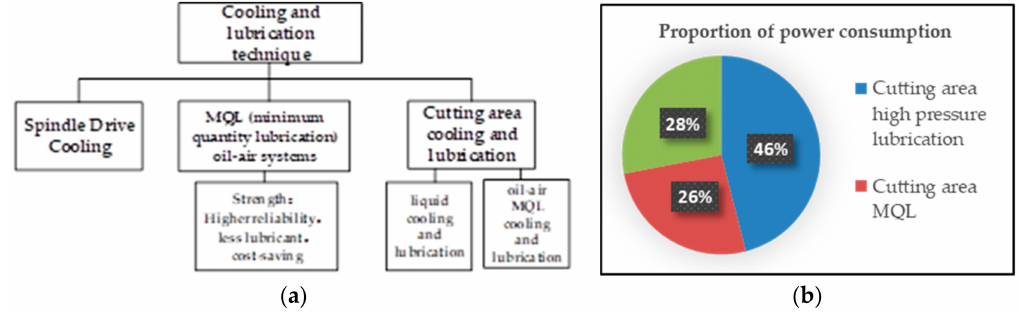
Figure 8. The cooling and lubrication technique. ( a ) The cooling and lubrication technique; ( b ) proportion of power